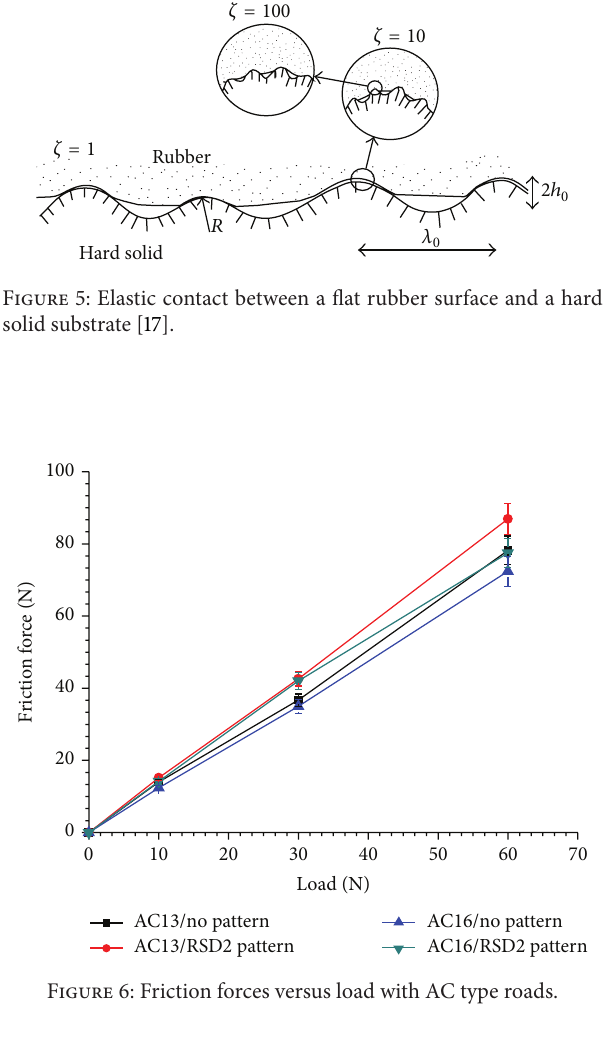
Figure 10: Meshing of the tread